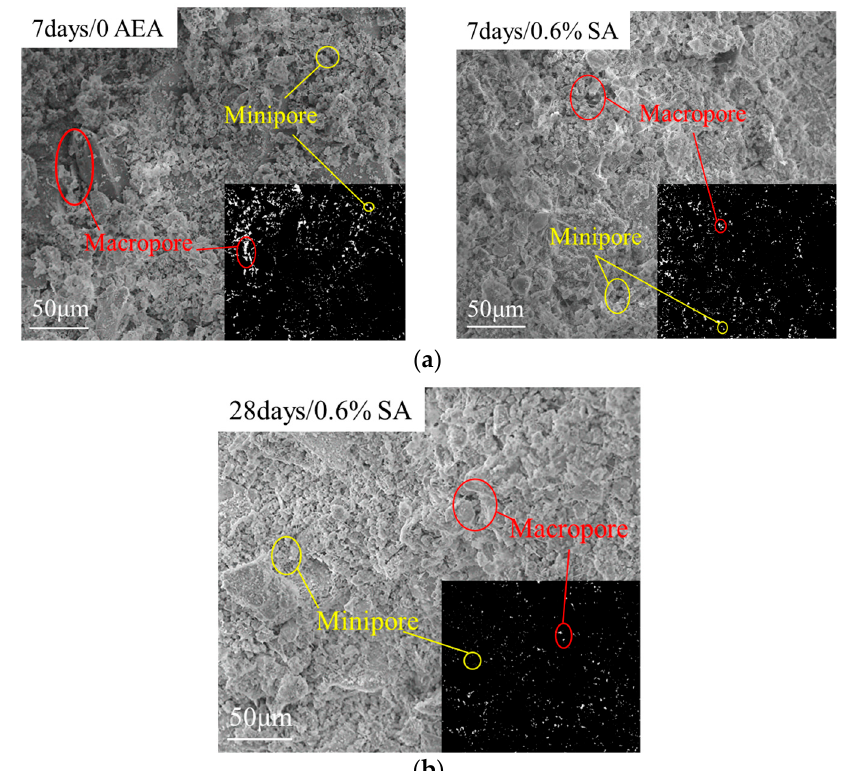
Figure 10. Porosity of air entraining agent fillings at different curing ages.